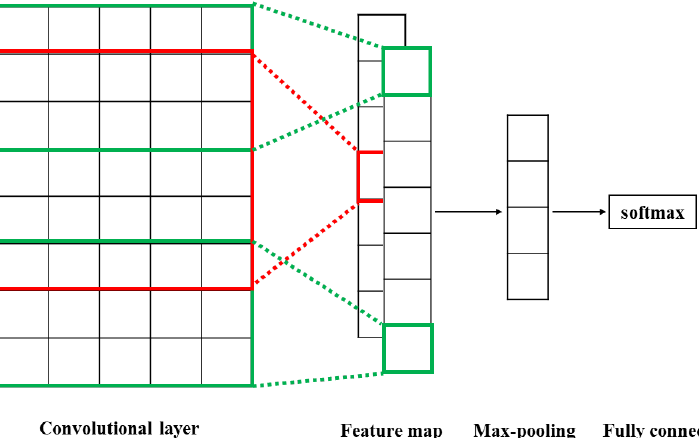
Figure 3. Structure of the classification module.